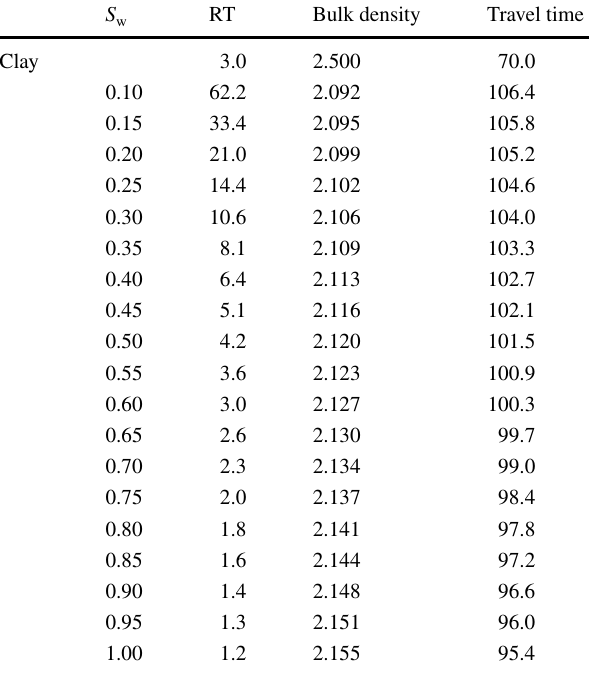
Φ = 10% c = 0, Φ = c = 25%,